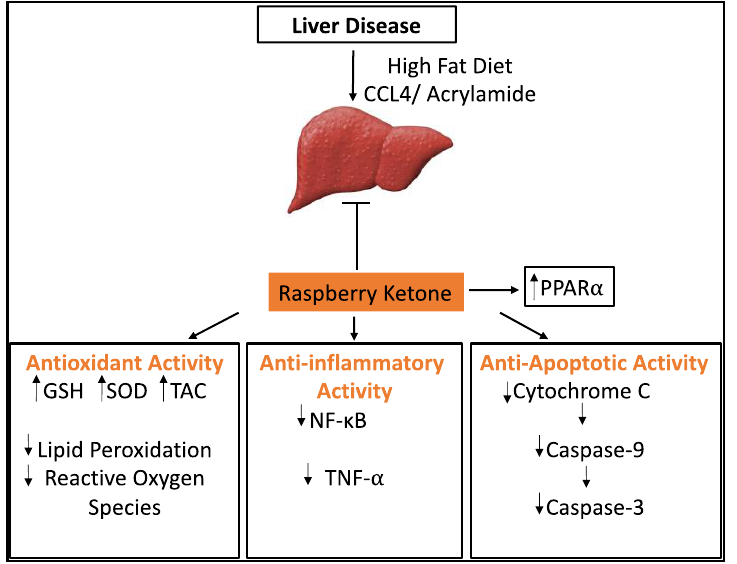
Figure 2. Schematic diagram showing the protective effects of RK against liver disease caused by a high-fat diet, CCL4, or acrylamide.